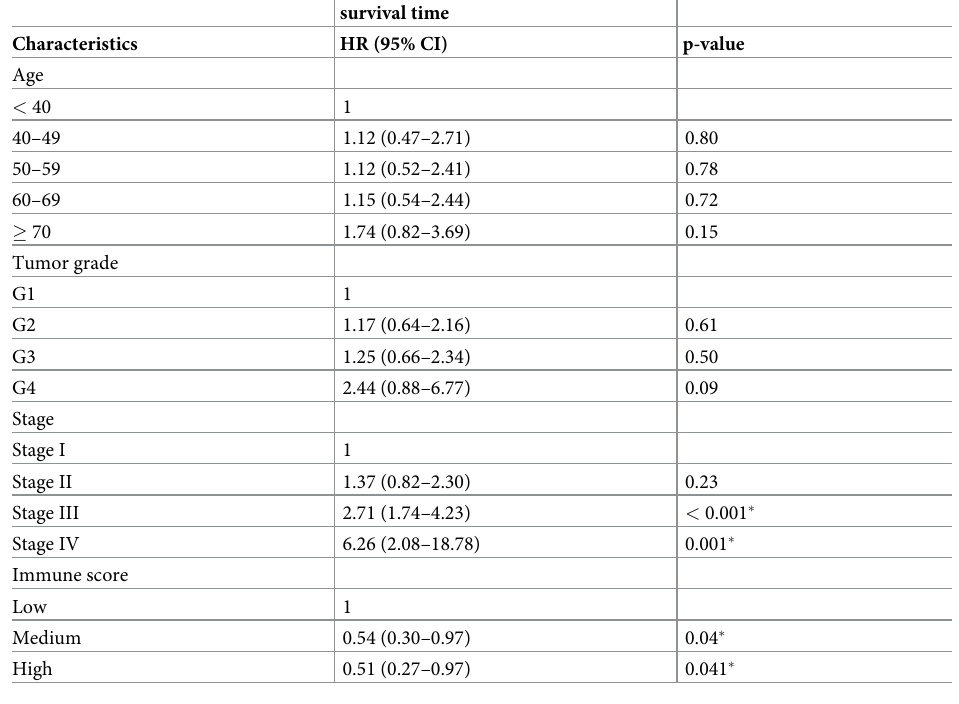
Table 2. Multivariate analyses of survival time among liver cancer patients according to clinical characteristics and immune